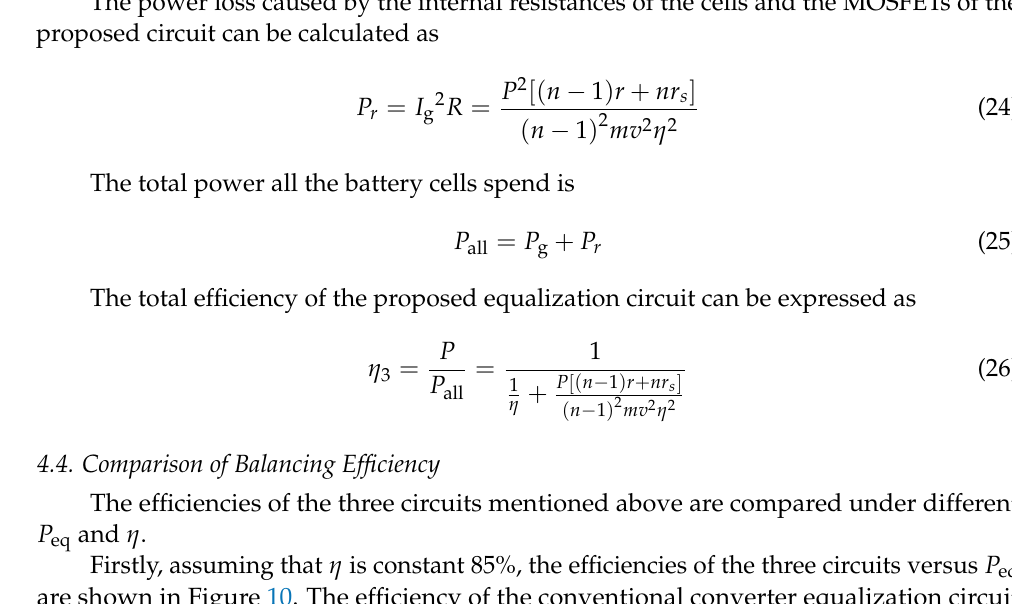
P . Figure 10. The total efficiency versus the equalization power P eq eq